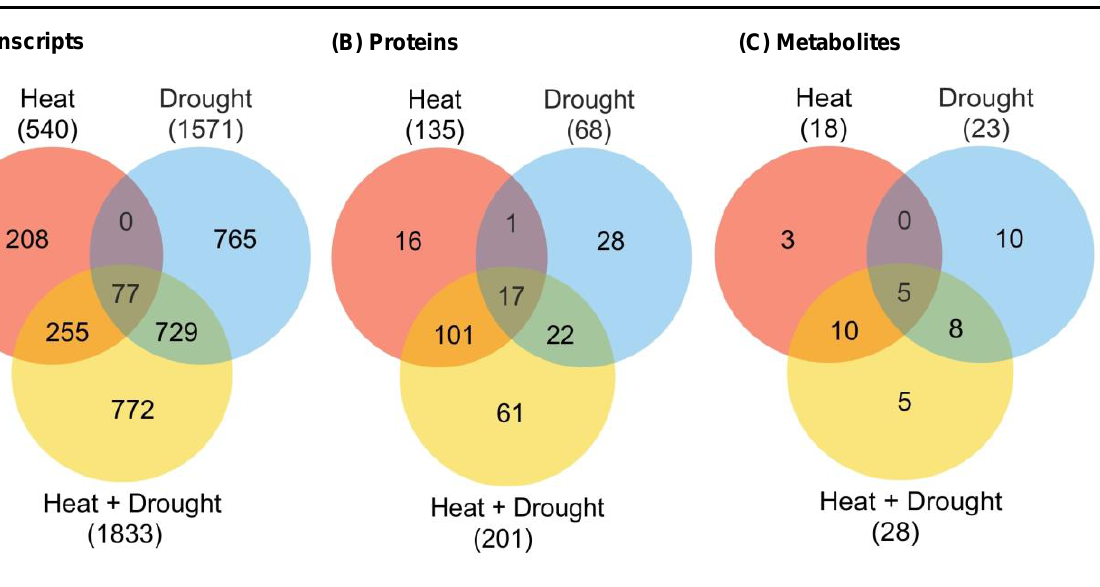
Figure 4. Unique characteristics of multi-omics studies under heat, drought and combined heat + drought stress. Venn diagram showing the overlap between ( a ) transcripts, ( b ) proteins, ( c ) metabolites (up-regulated or down-regulated) during heat or drought stress, or a combination of heat and drought stress. The total number of transcripts or metabolites is indicated in parenthesis. The stress-induced expression was based on a significant linear regression ( p < 0.01) and a threshold of ≥1.5 -fold (log 2 )over control [17,19].